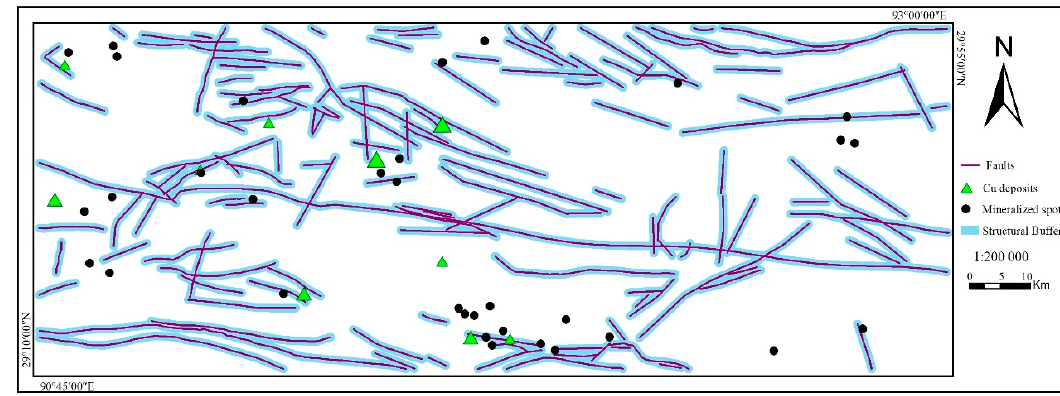
Figure 5. The structural buffer map.